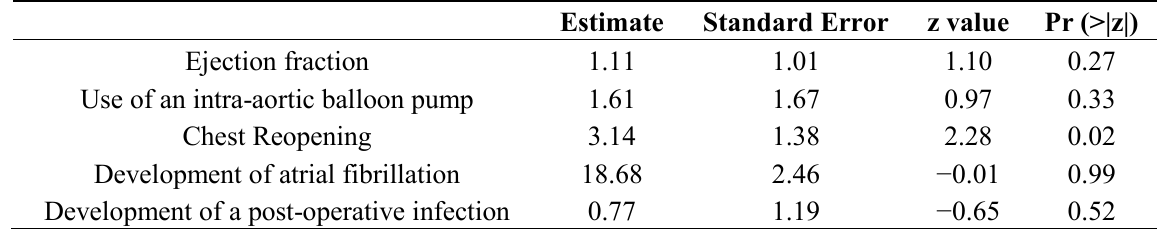
Table 6. Best fitted logistic regression model for elderly patients who underwent cardiac surgery. Estimate Standard